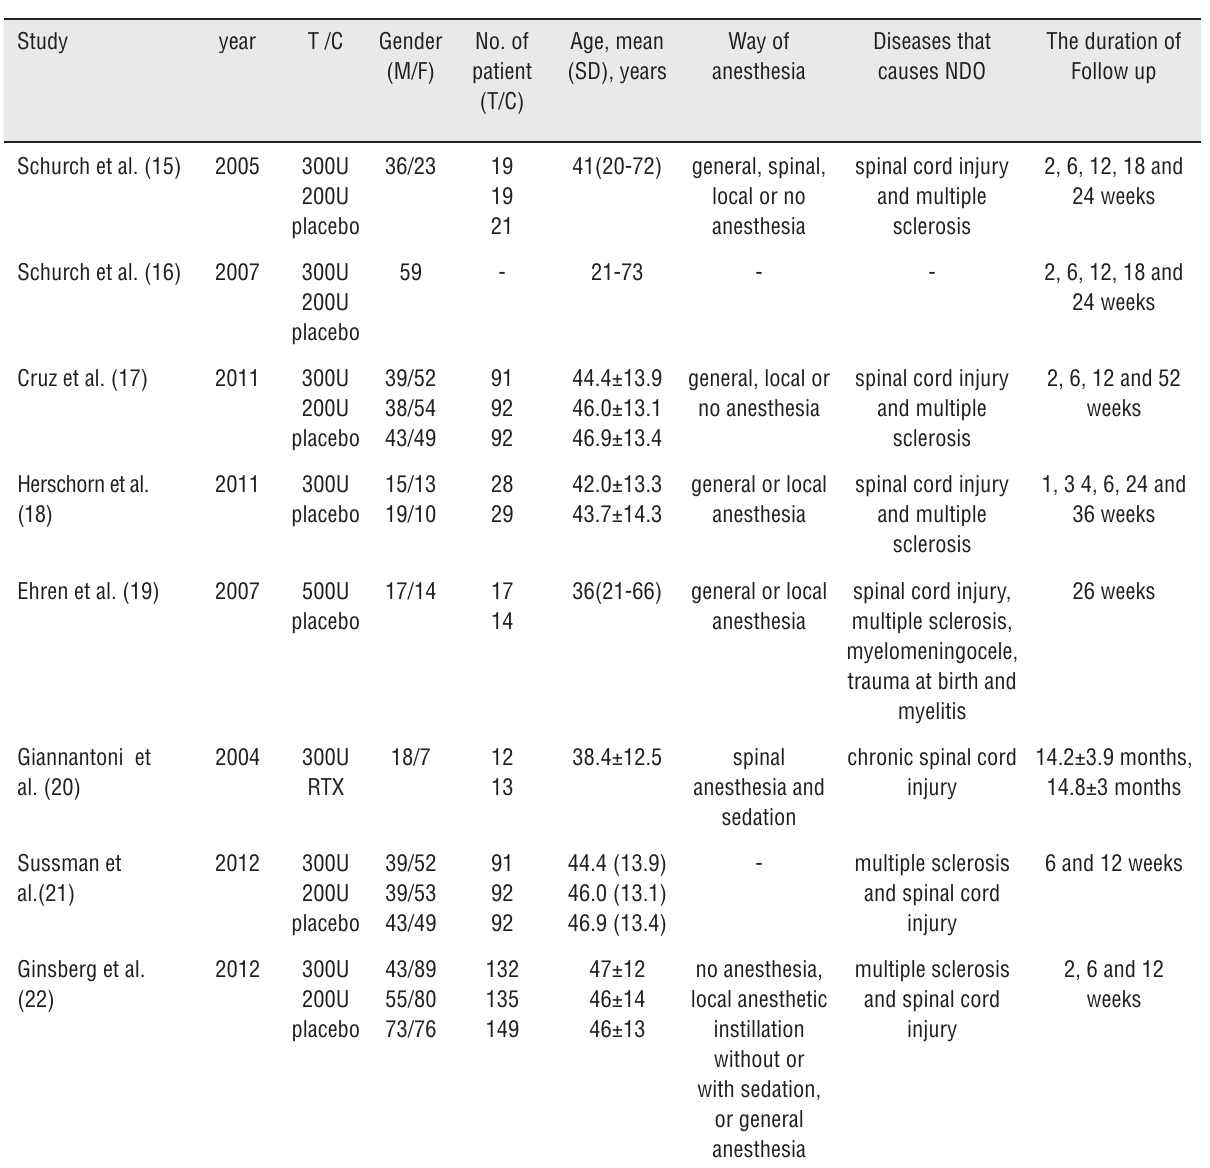
Table 1 - Characteristics of included